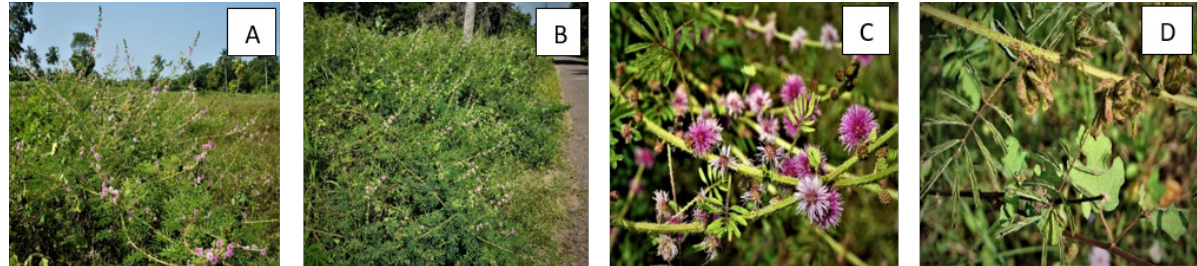
Figure 1: Mimosa diplotricha A) habit, wasteland near coconut plantation; B) roadside population, note – blue-green mature leaves below; C) flowering branches, note – 4-sided stem and each ridge with a row of re-curved spines; D) mature